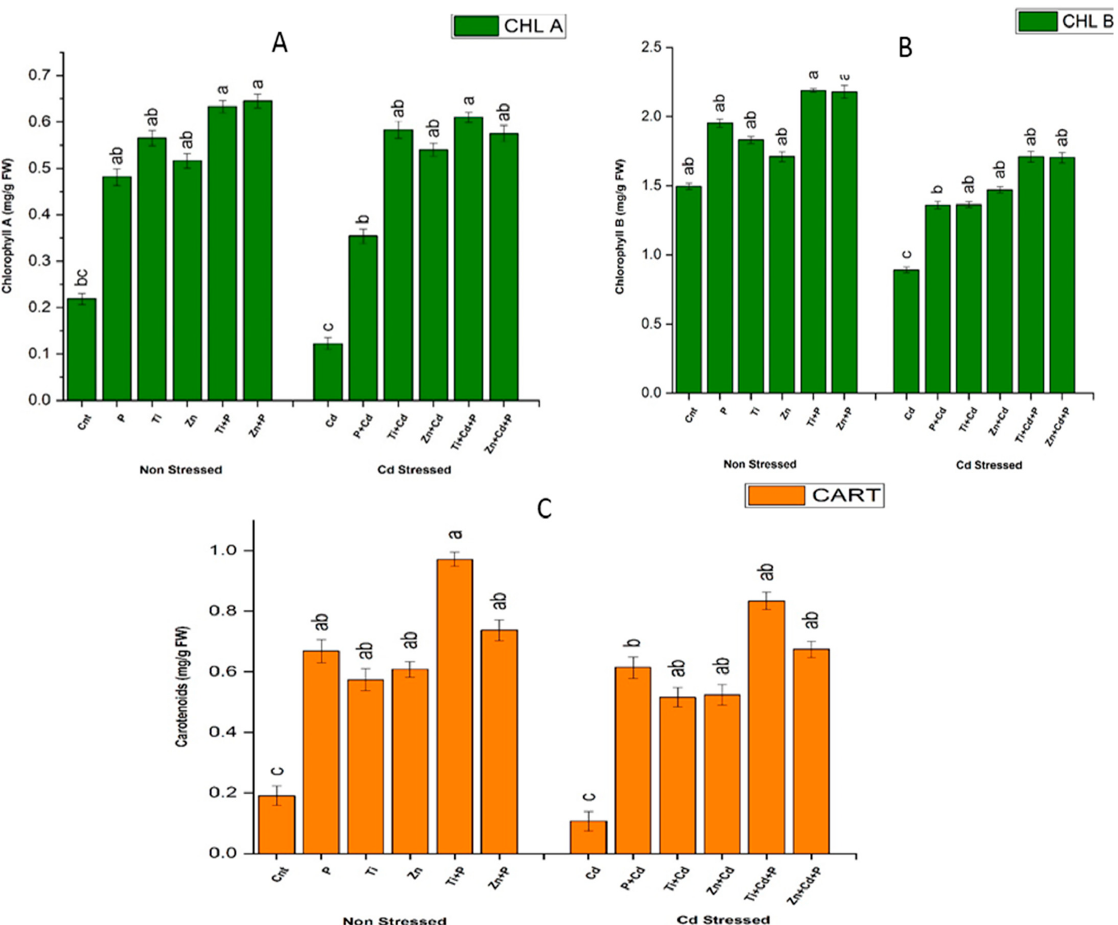
Figure 1. Effects of sole and combined treatments of plant-growth-promoting bacteria (PGPB) ( Bacillus pumilus ) and zinc oxide and titanium dioxide nanoparticles on ( A ) chlorophyll A, ( B ) chlorophyll B, and ( C ) carotenoid content. Cnt = non-treated, P = Bacillus pumilus , Ti = titanium dioxide nanoparticles, Zn = zinc oxide nanoparticles, Ti + P= titanium dioxide nanoparticles + Bacillus pumilus Zn + P = Bacillus pumilus + xinc oxide nanoparticles, Cd = cadmium stress, P + Cd = Bacillus pumilus + cadmium stress, Ti + Cd = Bacillus pumilus nanoparticles + cadmium stress, Zn + Cd = zinc oxide nanoparticles + cadmium stress, Ti + Cd + P = titanium dioxide nanoparticles + cadmium stress + Bacillus pumilus , Zn + Cd + P = zinc oxide nanoparticles + cadmium stress + Bacillus pumilus . To compare different mean values of all treatments, the least significant difference (LSD) was computed at p = 0.05.